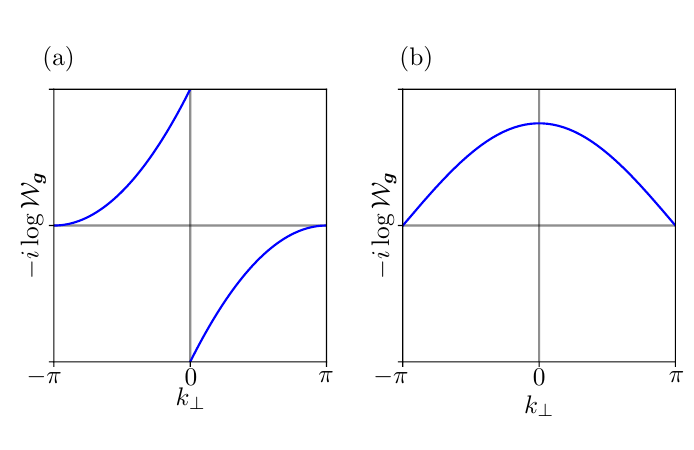
Figure 9: Example Wilson loop spectra of systems with (a) inversion symmetry (b) time-reversal